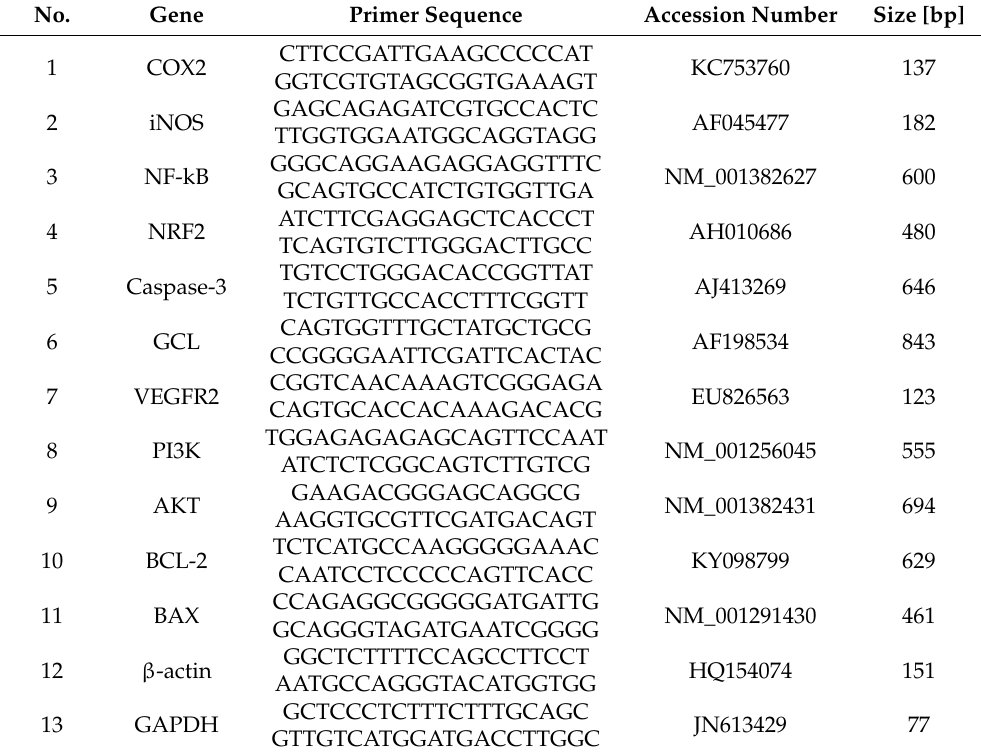
Table 1. Primer sequences used in